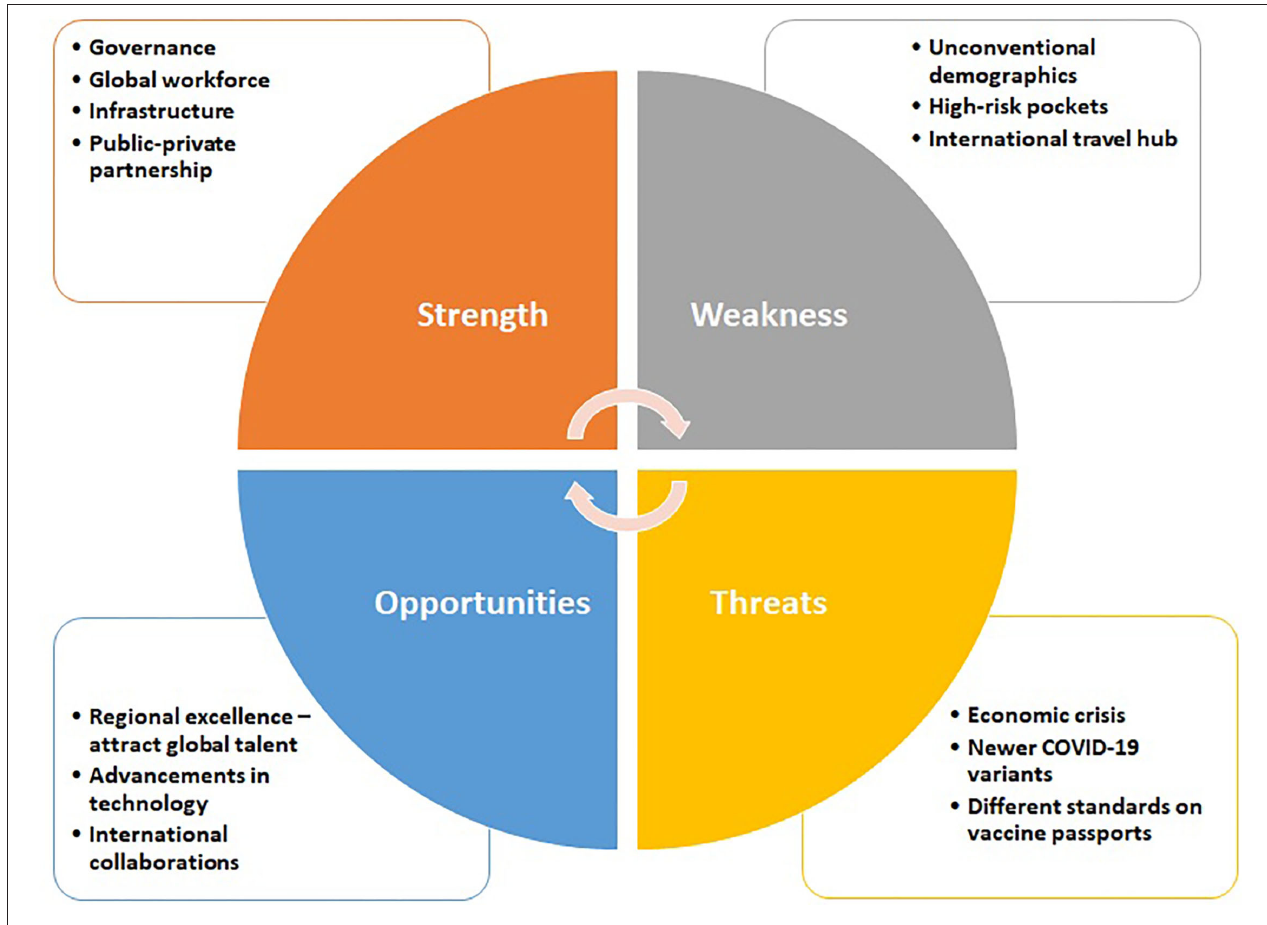
FIGURE 1 | SWOT analysis on management of pandemic in the